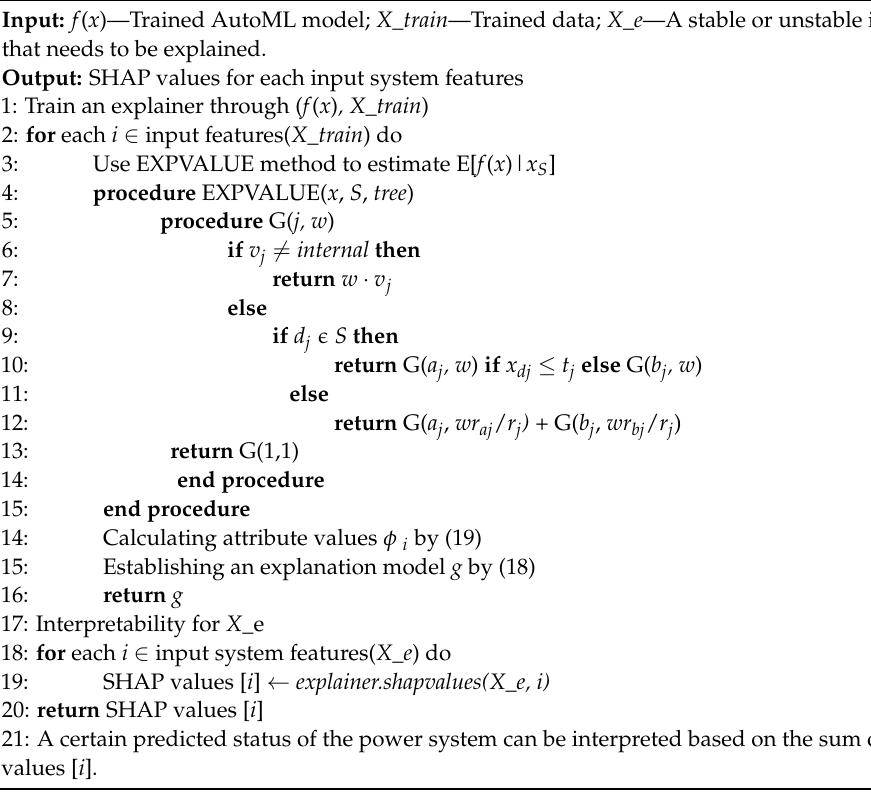
Algorithm 1. The process of interpretability